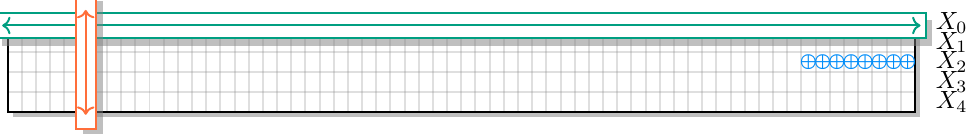
Figure 3: ANF of the S-box (left) and the linear layer (right) of Ascon